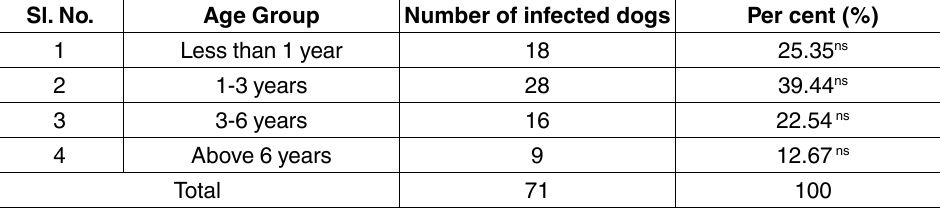
table 1. Age wise occurrence of bacterial dermatitis in dogs sl. No.